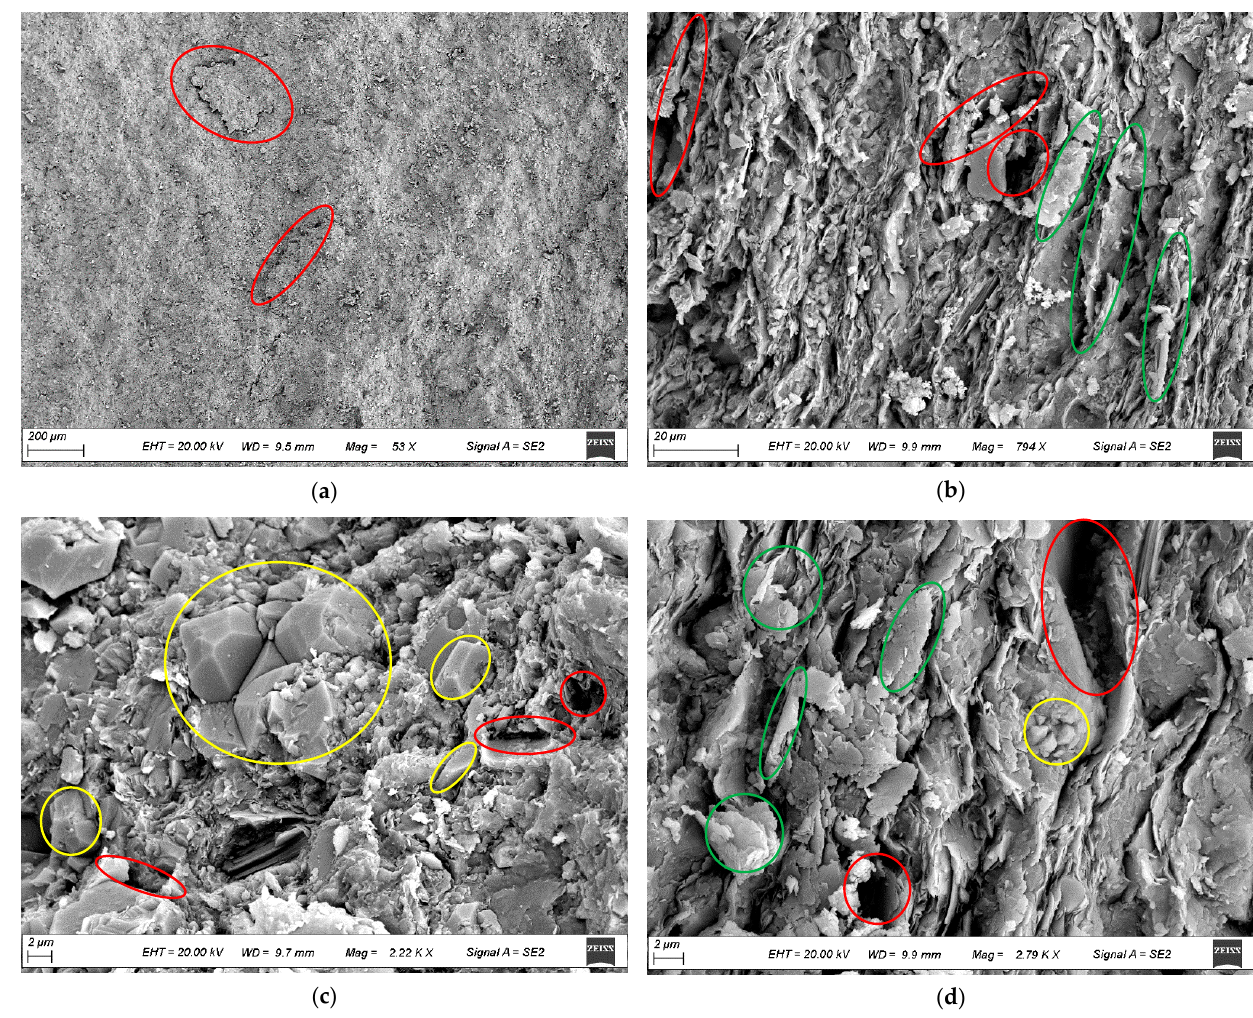
Figure 5. SEM images of core samples. ( a ) The full view of SEM image magnified 53 times shows that the rock was tight. ( b – d ) The SEM images magnified 794, 2220, and 2790 times show the clay minerals of lamellar illite, crystalline pyrite, and micropores/fractures, respectively. (Note: the red circles are pores and fractures, the yellow circles are crystalline pyrite, and the green circles are illite.).